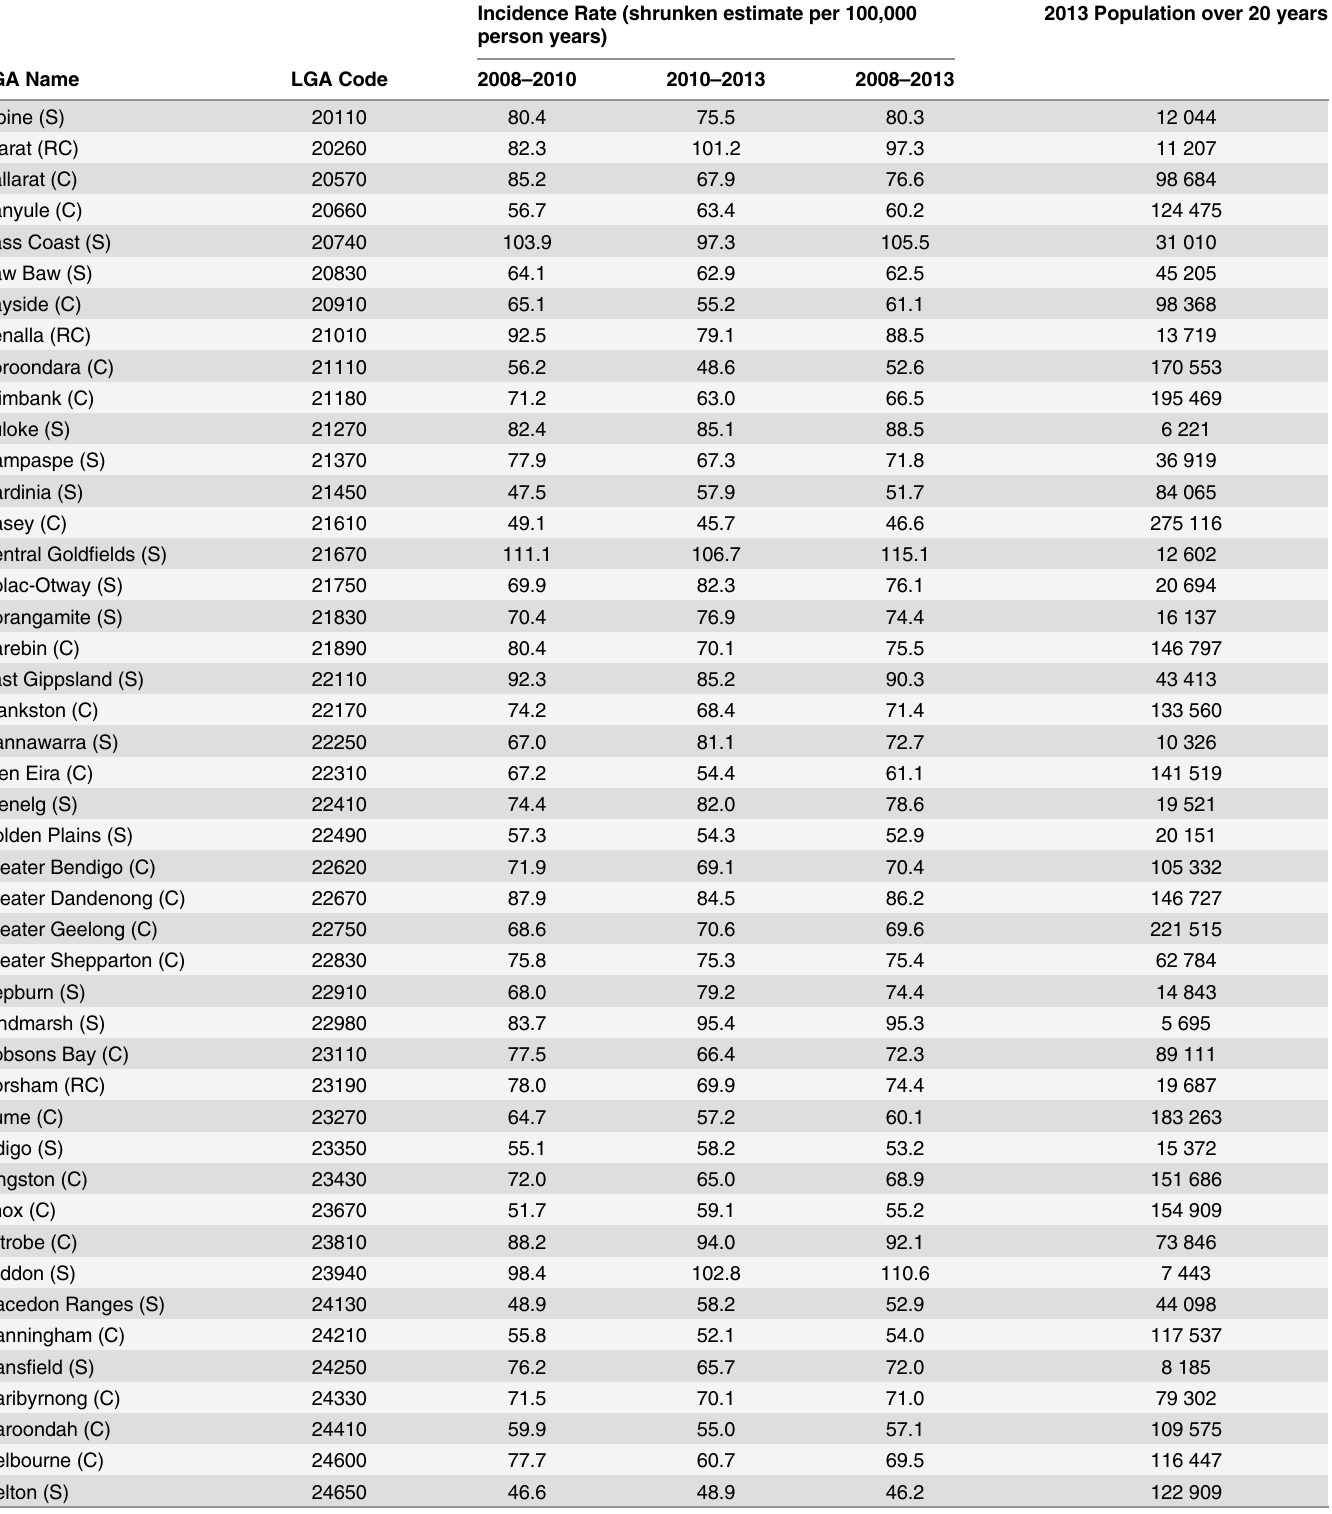
Table 1. Shrunken estimate of Out-of Hospital Cardiac Arrest incidence rate by Victorian Local Government Area, 2008 –